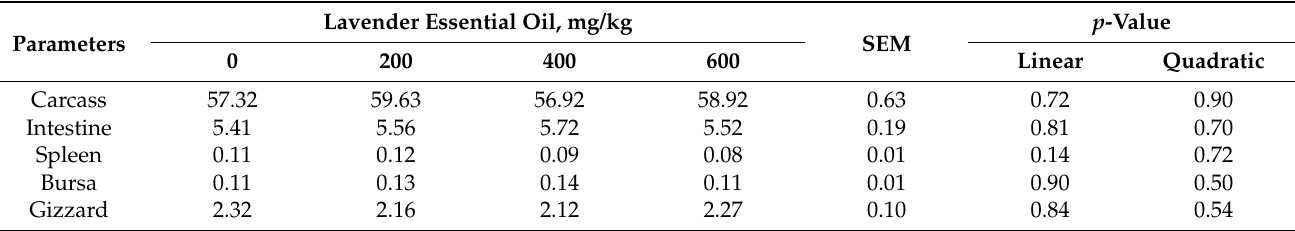
Table 4. Impact of lavender essential oil addition on the carcass traits (%) relative to live body weight.